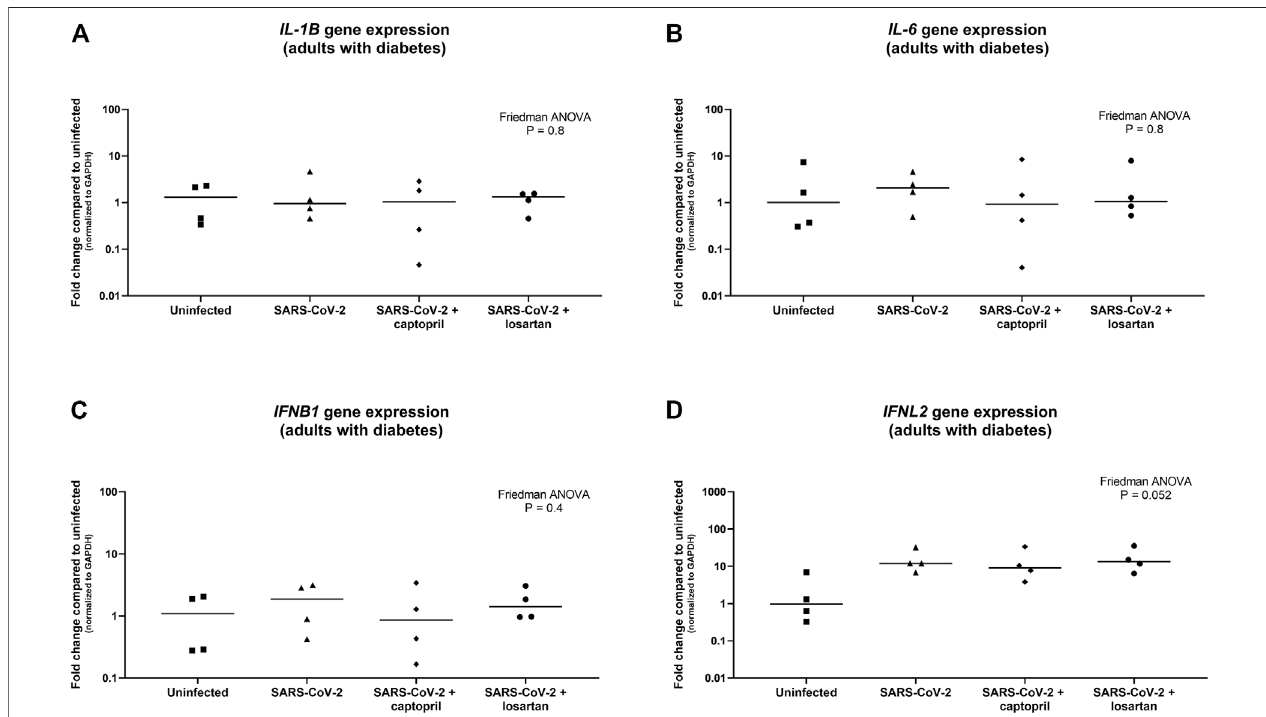
FIGURE 6 | Relative gene expression of IL-1B, IL-6, IFNB1 , and IFNL2 (normalized to GAPDH expression) by organotypic bronchial airway epithelial cell cultures from adults with type 2 diabetes ( n (cid:1) 4). Expression of IL-1B was not signi fi cantly different between uninfected,SARS-CoV-2 infected, or SARS-CoV-2 infected cultures withorwithouttreatmentwithcaptoprilorlosartan[ (A) FriedmanANOVA p (cid:1) 0.8].Expressionof IL-6 wasalsonotsigni fi cantlydifferentbetweenuninfected,SARS-CoV- 2 infected, or SARS-CoV-2 infected cultures with or without treatment with captopril or losartan [ (B) Friedman ANOVA p (cid:1) 0.8]. Expression of IFNB1 was not signi fi cantly different between uninfected, SARS-CoV-2 infected, or SARS-CoV-2 infected cultures with or without treatment with captopril or losartan [ (C) Friedman ANOVA p (cid:1) 0.4], however, there was a trend toward greater expression of IFNL2 by SARS-CoV-2 infected cultures compared to uninfected cultures [ (D) Friedman ANOVA p (cid:1) 0.052]. There was no difference in IFNB1 or IFNL2 expression between SARS-CoV-2 infected cultures with or without treatment with captopril or losartan. Median indicated by bold lines and quartiles indicated by dashed